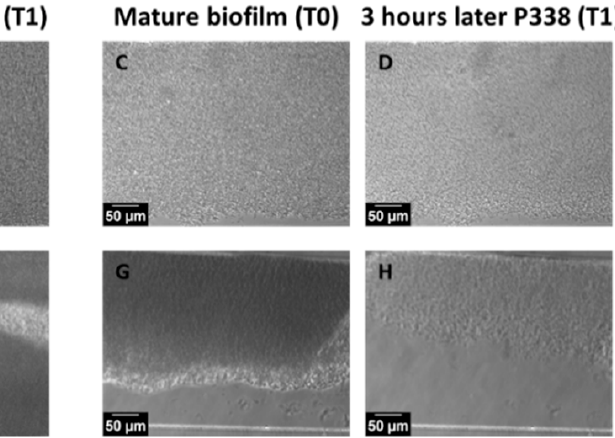
Figure 3. Early anti-biofilm activity of P338 detected by frames extrapolated from BioFlux time- lapse recording: BioFlux images of 15 h old Ec5FSL ( A , C ) and Ec9FSL ( E , G ) biofilms, and 3 h after the instillation of PBS ( B and F , respectively) and 0.5% P338 solution ( D and H , respectively). Ac- quisition was performed with a 20×, 3.1 WD objective.